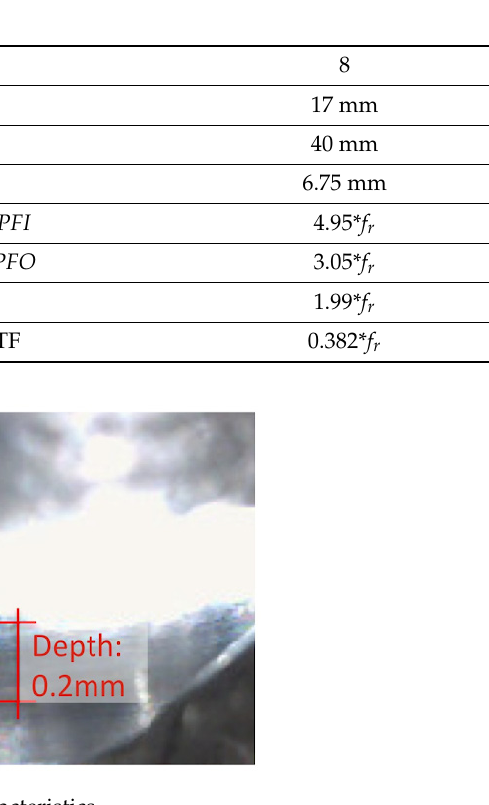
Figure 3. Bearing inner race defect characteristics. Vibration signals are captured from an accelerometer model KCF AG107M, placed along vertical direction on a test bearing external housing with a specification in Table